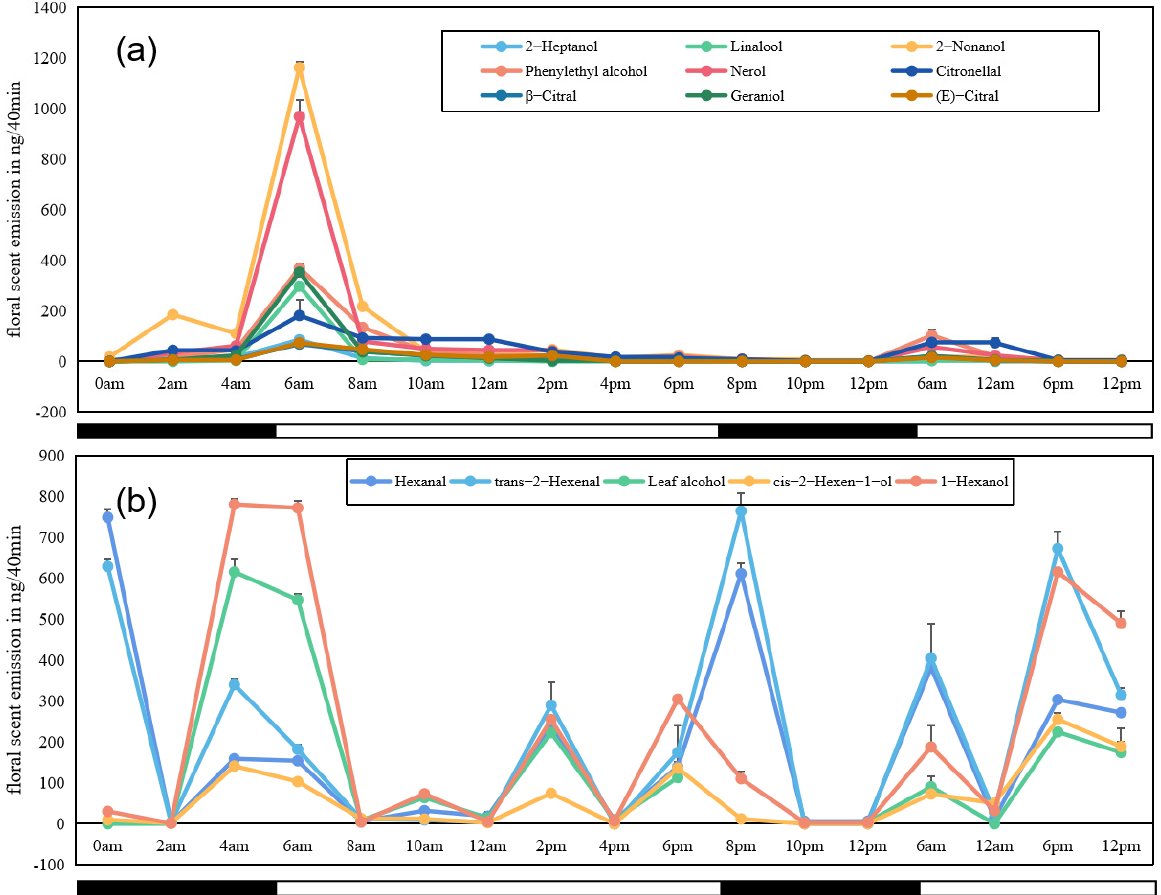
Figure 4. Time courses of emissions of 14 major VOCs identified from flowers of L. caudata during a 48-h sampling period. ( a ): Nine compounds showing similar emission patterns; ( b ) five com- pounds showing similar emission patterns. Open bars, daytime with light availability; solid bars: nighttime/darkness.